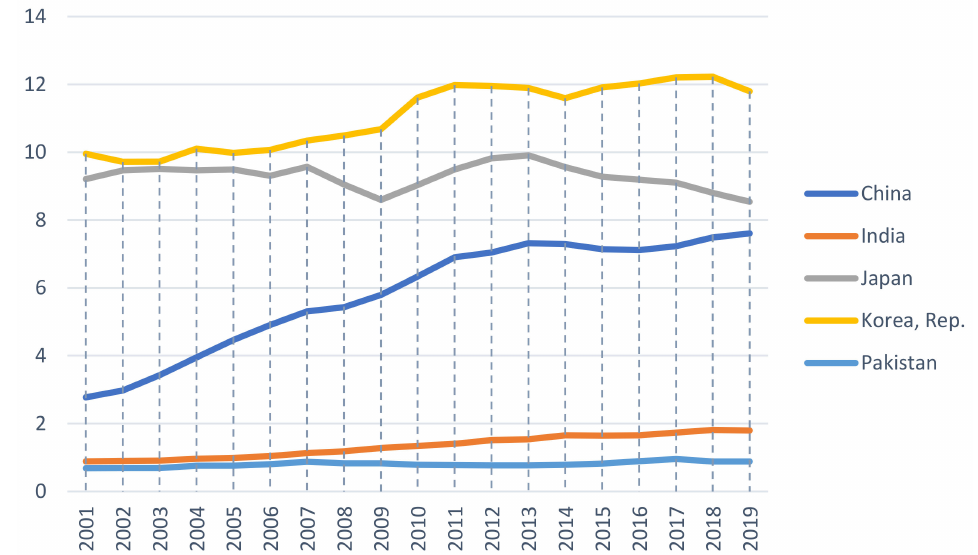
Figure 1. CO 2 emission in selected Asia Pacific countries source: Global footprint network [17].